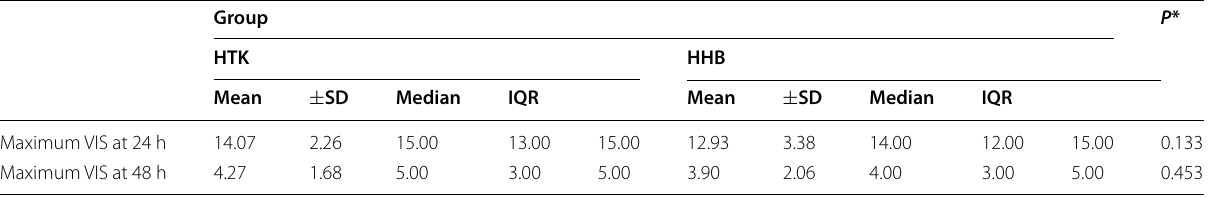
VIS vasoactive inotropic score, HTK histidine-tryptophan-ketoglutarate, HHB hypothermic hyperkalemic blood, SD standard deviation, IQR interquartile range; *Student’s t